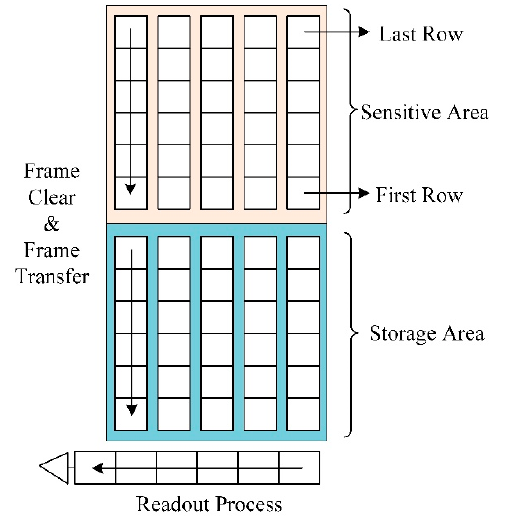
Figure 3. Frame clear, frame transfer and readout processes of the CCD.